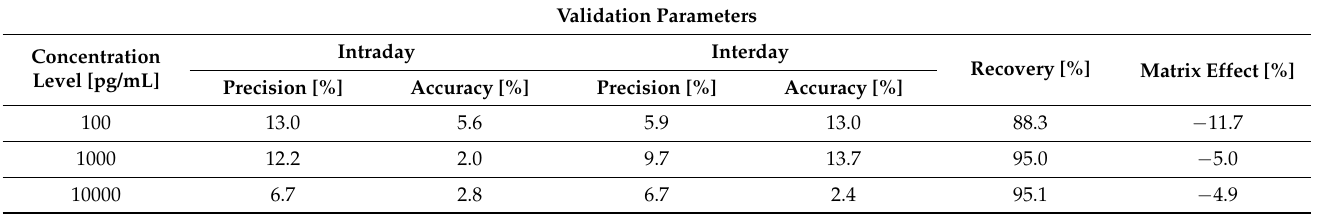
Table 2. Validation parameters of the UHPLC-QqQ-MS/MS method for determination of misoprostol acid in postmortem whole blood samples.